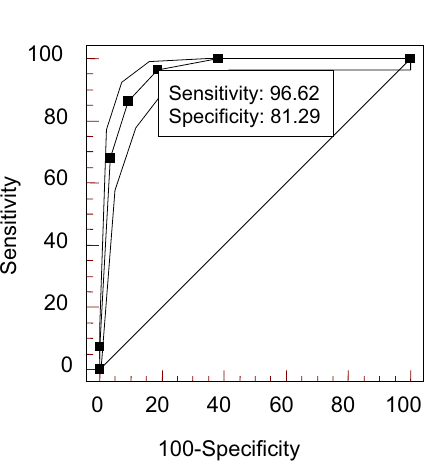
Figure 1. ROC curve analysis for ANA titer. ANA antinuclear